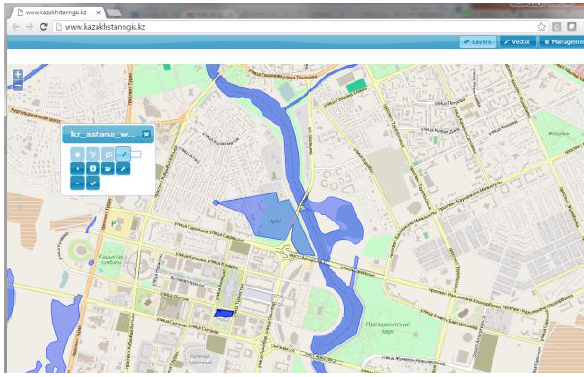
Figure 5. Kazakhstan NGIS Portal